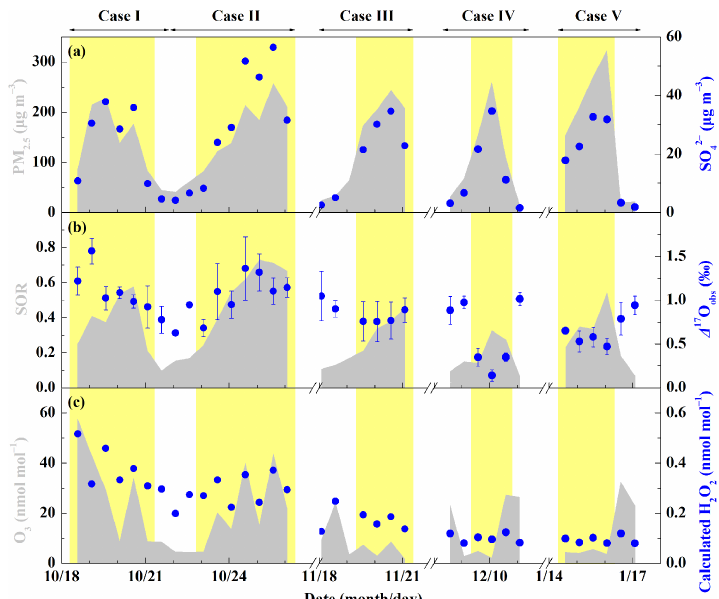
Figure 1. Characteristics of haze events in Beijing (October 2014–January 2015). (a) Temporal evolution of PM 2 . 5 and SO 2 − concentrations. 4 (b) Temporal evolution of sulfur oxidation ratio (SOR, which equals SO 2 − molar concentration divided by the sum of SO 2 − and SO 2 4 4 molar concentration) and observed (cid:49) 17 O(SO 2 − ) ( (cid:49) 17 O obs ). (c) Temporal evolution of observed O 3 and calculated H 2 O 2 . The error bar of 4 (cid:49) 17 O obs in (b) is ± 1 σ of replicate measurements ( n = 2–4) of each sample. The light yellow shaded area indicates polluted days (PDs, PM 2 . 5 ≥ 75µgm − 3 ). Data used here are 12-hourly averaged values, corresponding with filter samples.